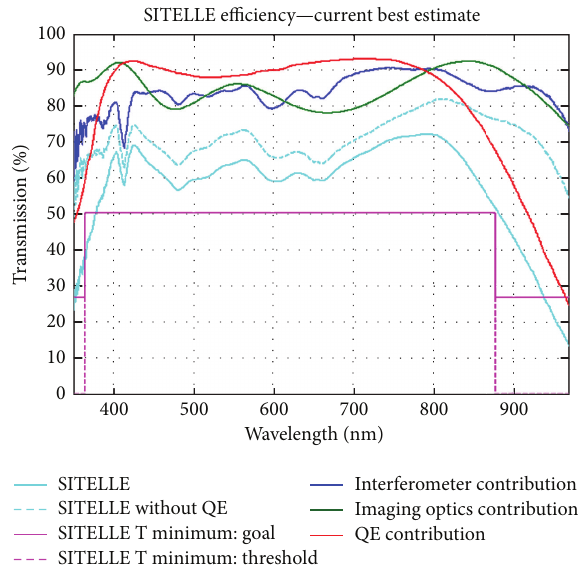
Figure 13: Strength of the NaD absorption line in the spectra of M87 at different galactocentric radii obtained from the SpIOMM data cube with two different methods and compared with Davidge [17].